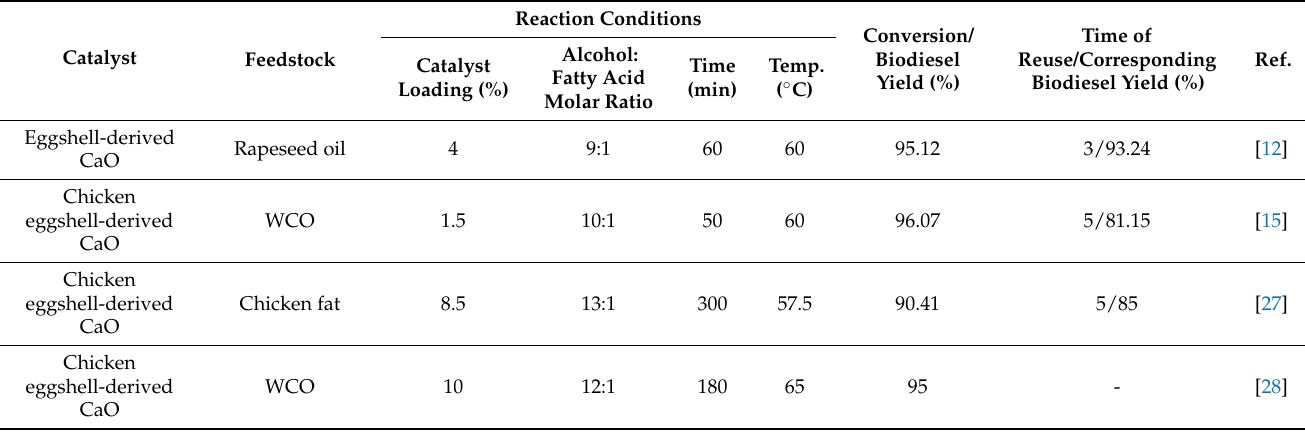
Table 1. Several bio-derived alkali catalysts for biodiesel